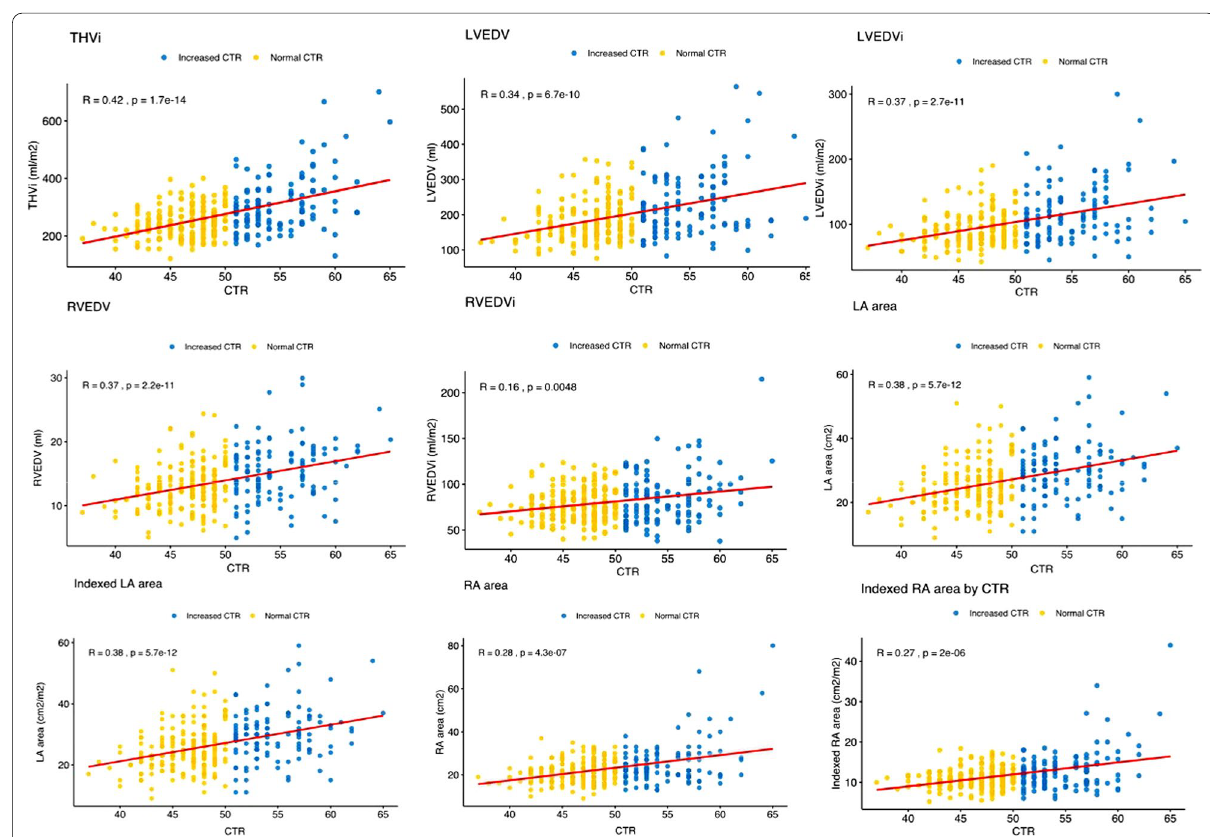
Fig. 3 Scatterplots including correlation lines between CTR and cardiac volumes and areas. Yellow dots represent patients with CTR < 50%, blue dots patients with CTR > 50%. Although there is a weak trend for patients with larger CTR to have larger ventricular volumes and atrial areas, the majority of measured cardiac MRI parameters are noted in both individuals with normal and increased CTR. THVi total heart indexed volume, LVEDV left ventricular end-diastolic volume, LVEDVi left ventricular indexed end-diastolic volume, RVEDV right ventricular end-diastolic volume, RVEDVi right ventricular indexed end-diastolic volume, LA left atrium, CTR cardiothoracic